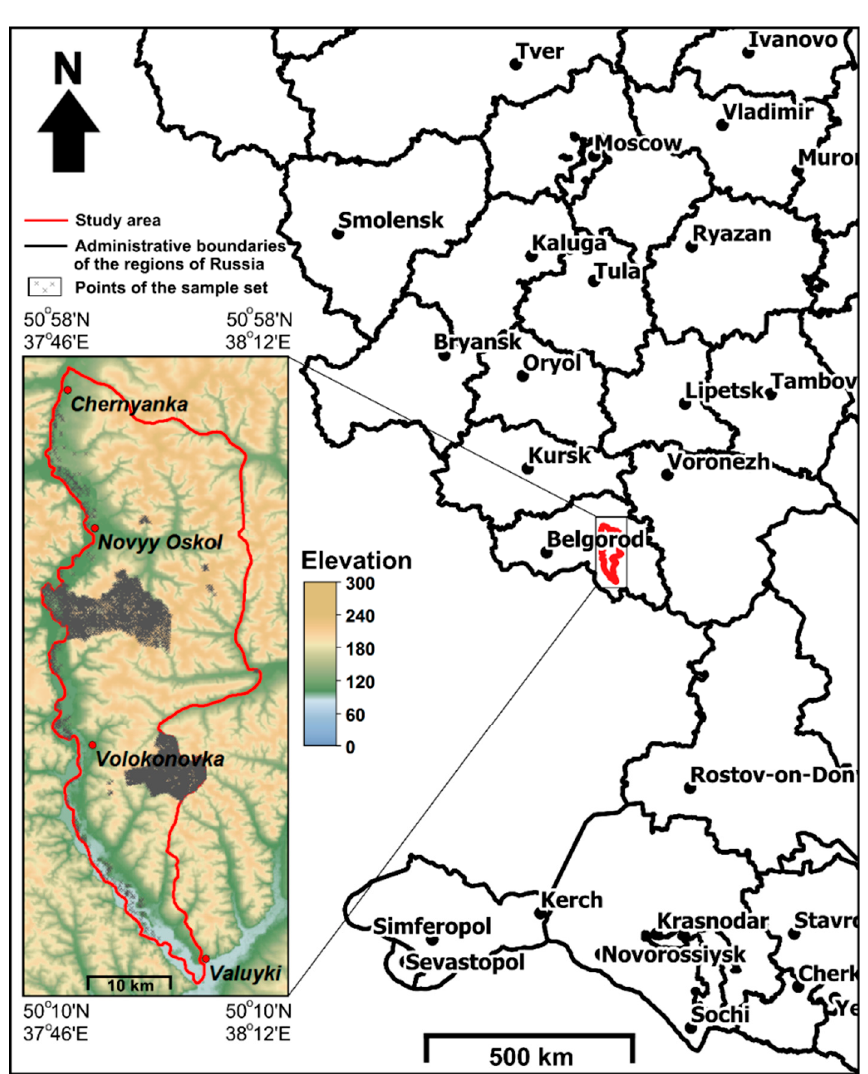
Figure 1. Study area Novy Oskol.